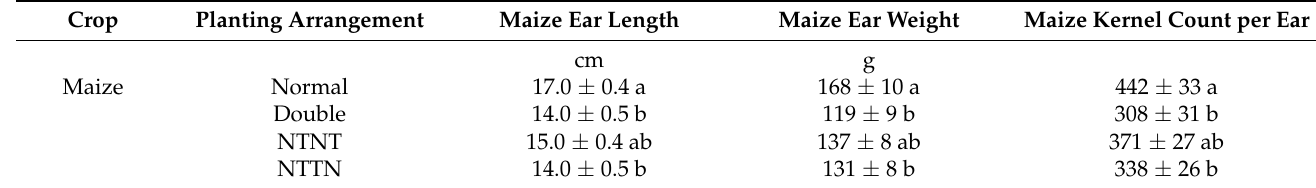
Table 5. Maize ear length, ear weight, and kernel count measurements for each planting arrangement. NTNT: a sequential arrangement of normal and tripled densities (each in every other row), and NTTN: normal-tripled-tripled-normal. Means and standard error of the means followed by a different letter indicate significant differences at p <